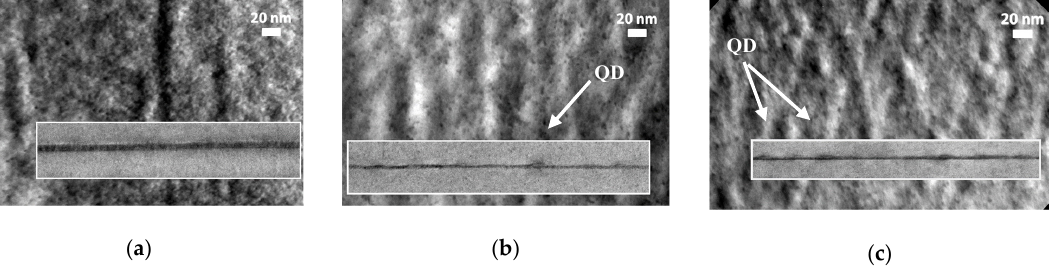
Figure 2. Plan-view (001) TEM images of the samples of the In x Ga 1 − x As QWD layers with nominal indium composition x = 0.3 ( a ), 0.4 ( b ), and 0.5 ( c ) (effective vector of diffraction g = (220)). Insets show a cross-section of images of the same samples in the [1–10]